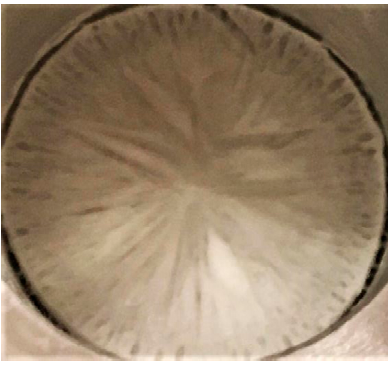
Figure 7. The photograph of the partially dried sample after 11.5 h (top view) reveals a star-like pore structure with long lamellar pores in the center and a rosette with smaller pores at the